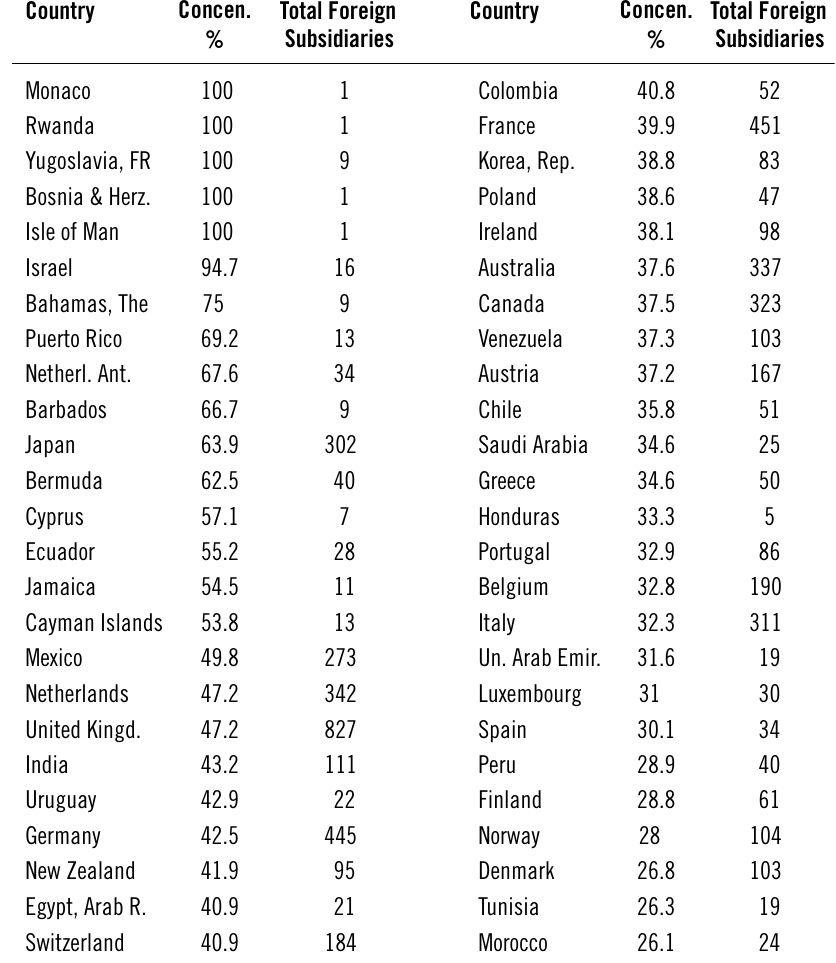
Table 3 (Cont.) – Countries Dominated by US Subsidiaries 1971 (IND 100) Concen.